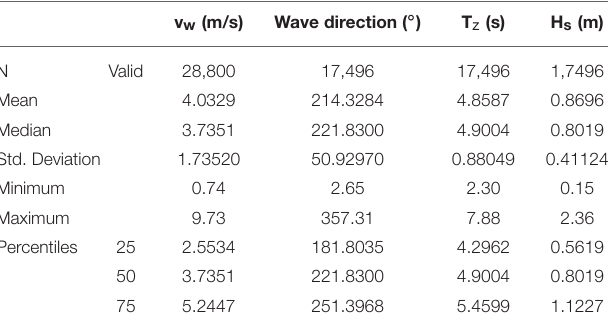
TABLE 1 | Main statistics of the wind and wave parameters.